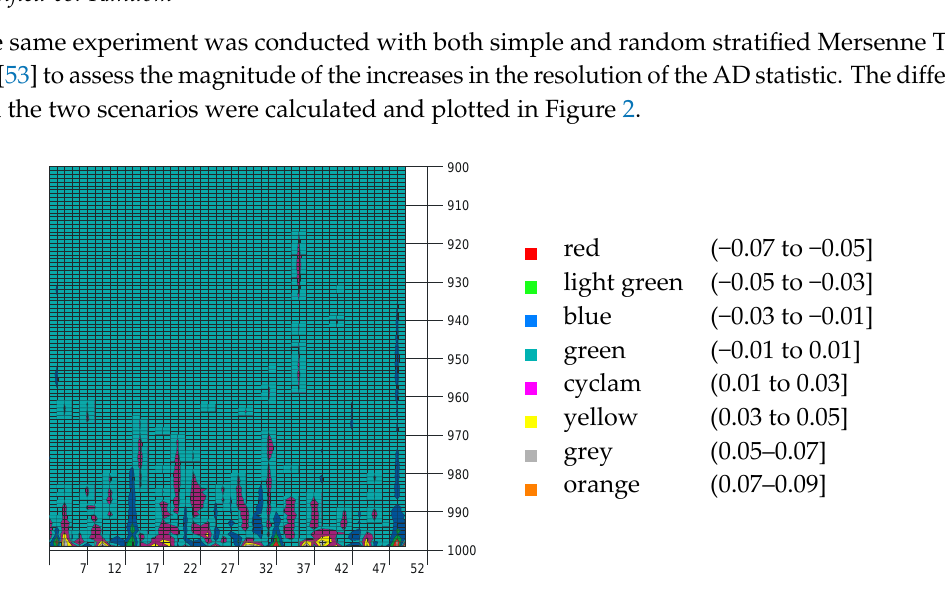
Figure 2. The effect in differences between classical and stratified random in calculated AD statistic.